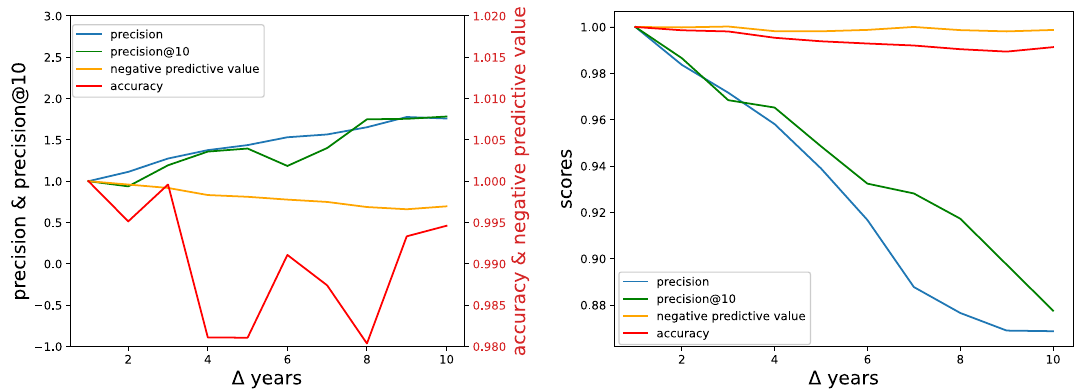
Figure 8. In the plot on the left we show the performance indicators in the case of the activations prediction task. The performance on positive values improves, while the one on negative values gets worse. On the right we show the same performance indicators in the case of the full matrix prediction task. All the scores get worse due to the vanishing auto-correlation of the